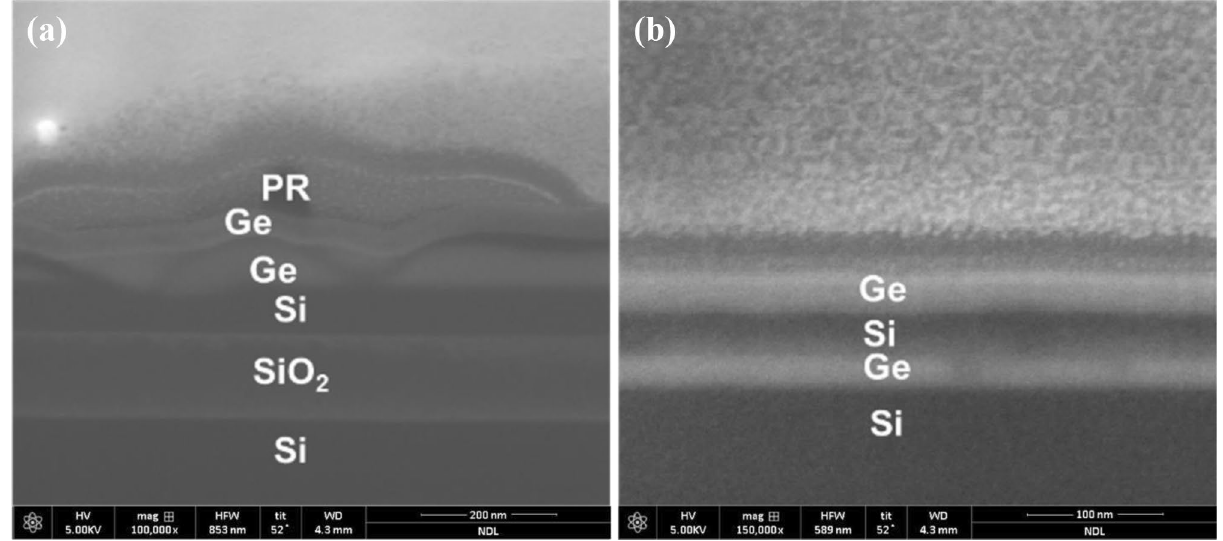
Figure 1. SEM images of Ge/Si multilayers. Low-temperature growth of the Si layer and ensuring that the growth process is not interrupted in the switching period between Ge and Si assist in transforming the layers from ( a ) island growth to the ( b ) 2D growth mode, despite the large Ge/Si